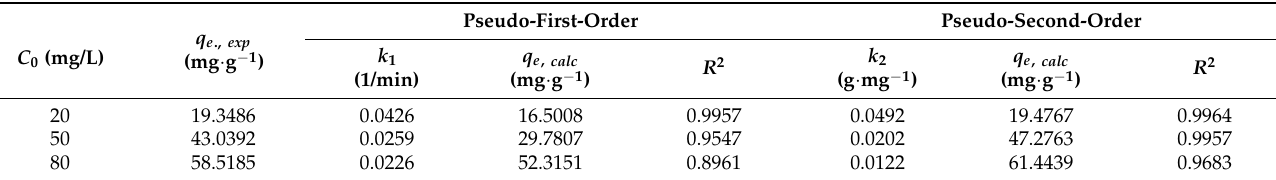
Figure 6. Pseudo−first−order model ( a ), pseudo−second−order model ( b ), Elovich model ( c ), and Intraparticle diffusion model ( d ) of MO on CoO@C-500; Langmuir ( e ) and Freundlich ( f ) model fitted adsorption isotherms of CoO@C-500. Table 2. Kinetic parameters for the adsorption of MO on CoO@C-500.